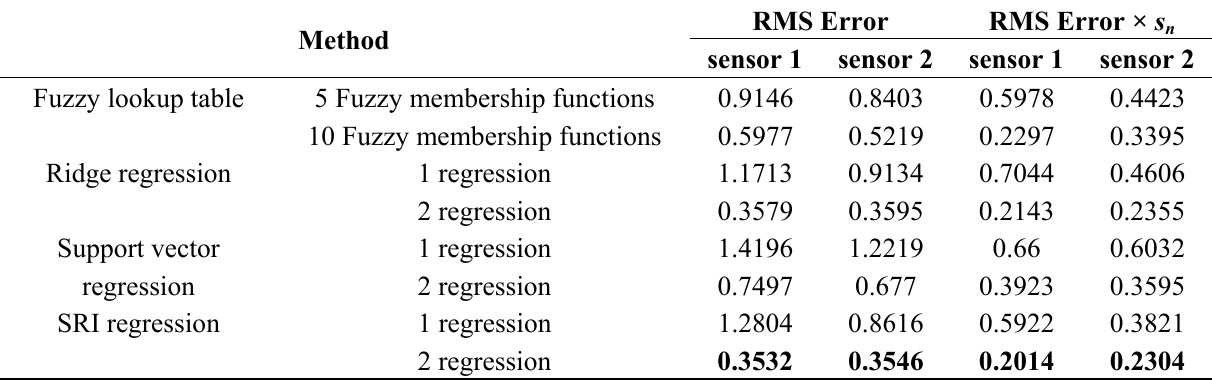
Table 1. Regression results of fuzzy lookup table method, ridge regression, support vector regression, and SRI regression ( p =10, β test data. (unit: cm).